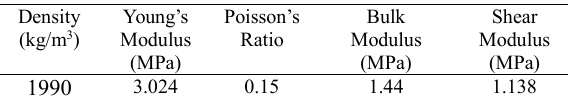
Table 1. Material parameters for